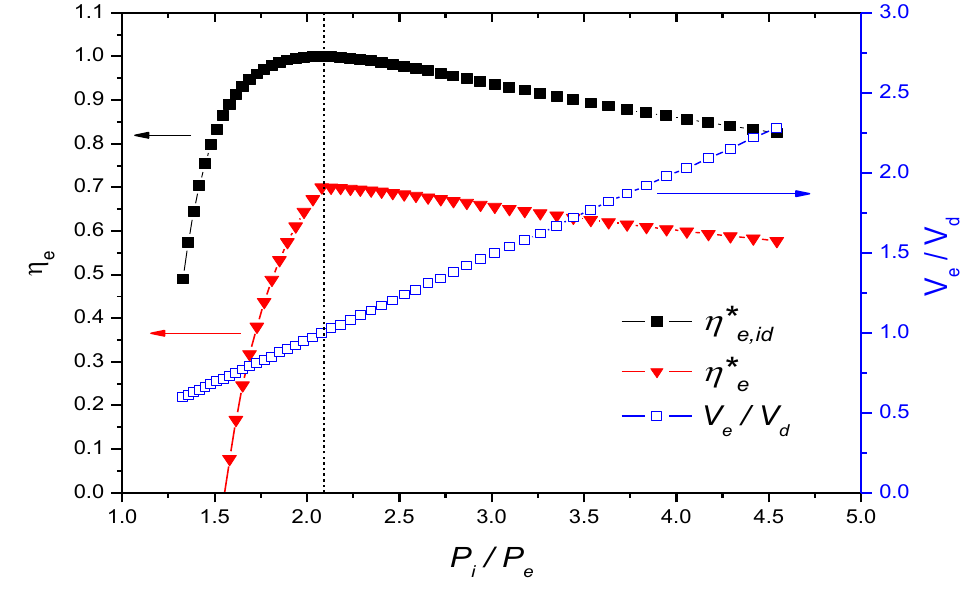
Figure 6. Effective expansion efficiency with imposed pressure ratio in the LT